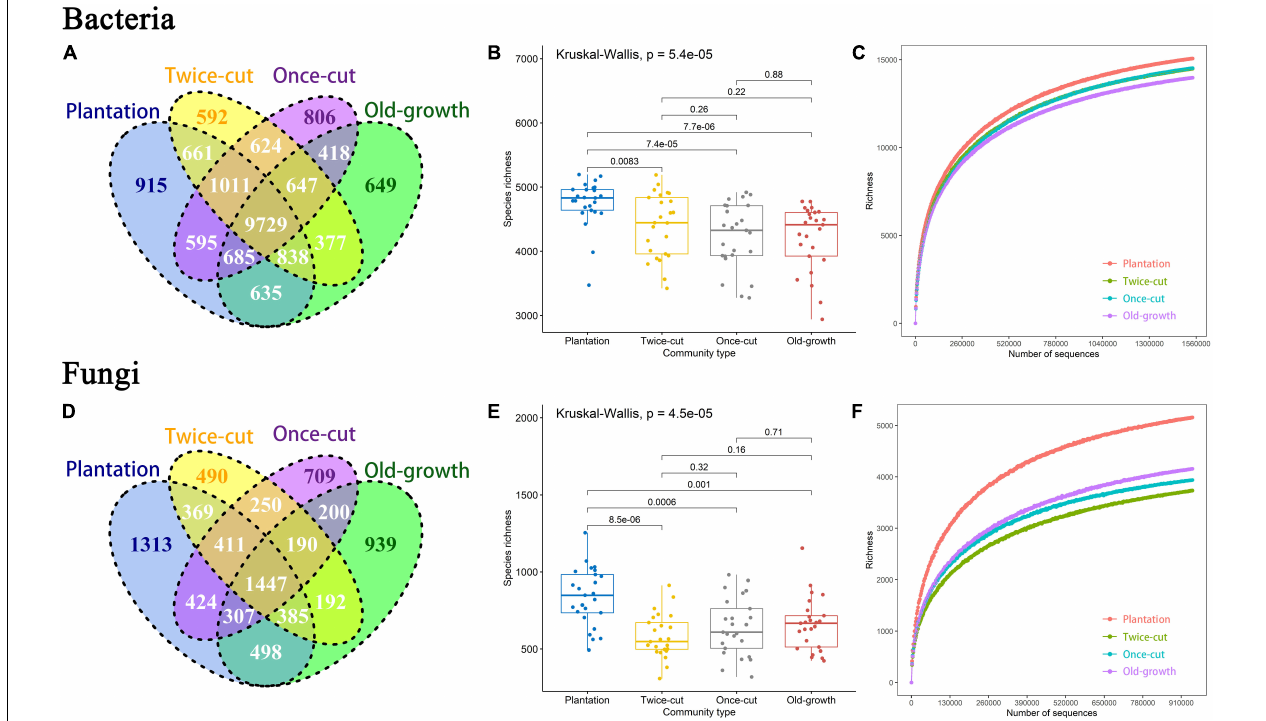
FIGURE 2 | Distribution differences of bacterial and fungal OTU diversity in different forest succession. (A,D) Are the number of OTU of bacteria and fungi in different forest succession. (B,E) Are the OTU richness of bacteria and fungi in the four forest succession. The black lines obtained by the Kruskal-Wallis method indicate significant differences. (C,F) Are the rarefaction curve of bacteria and fungi in the four forest succession at the OTU level. Different colored curves indicated different types of succession ( P ≤ 0.05 was the significance